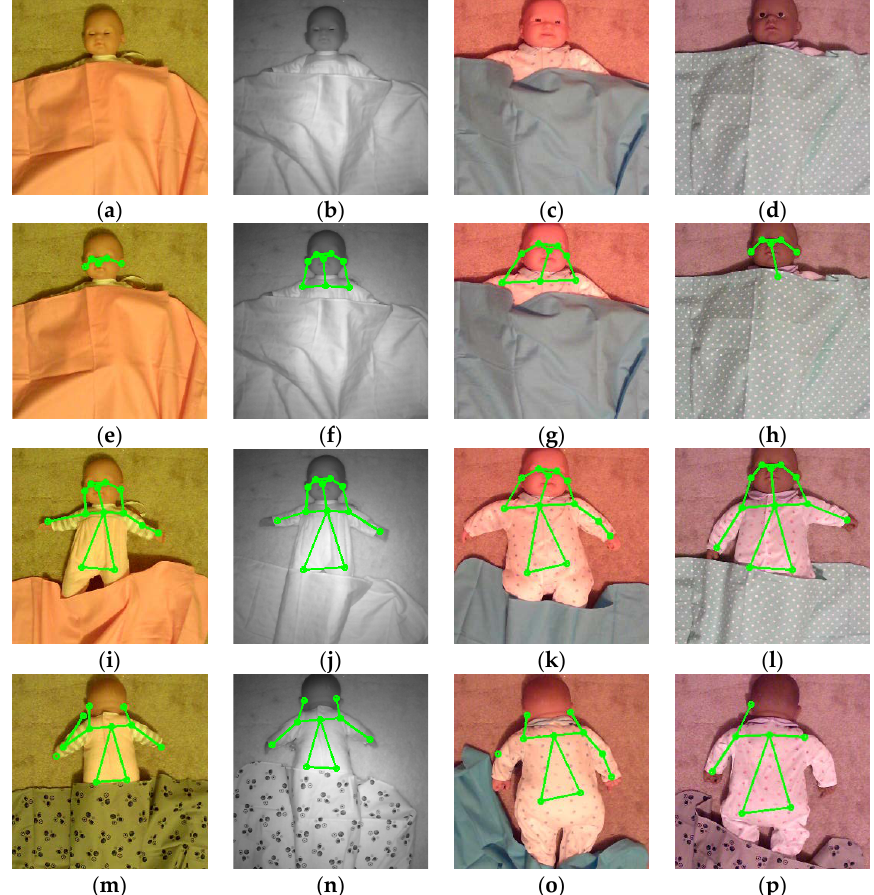
Figure 10. ( a – d ): captured images of dolls with a blanket in the day and night conditions; ( e – h ) lower body parts not detected, indicating blanket is not removed; ( i – l ) lower body parts (such as hips) detected, indicating blanket is removed; ( m – p ) nose undetected and lower body parts detected, indicating face is covered and blanket is removed.